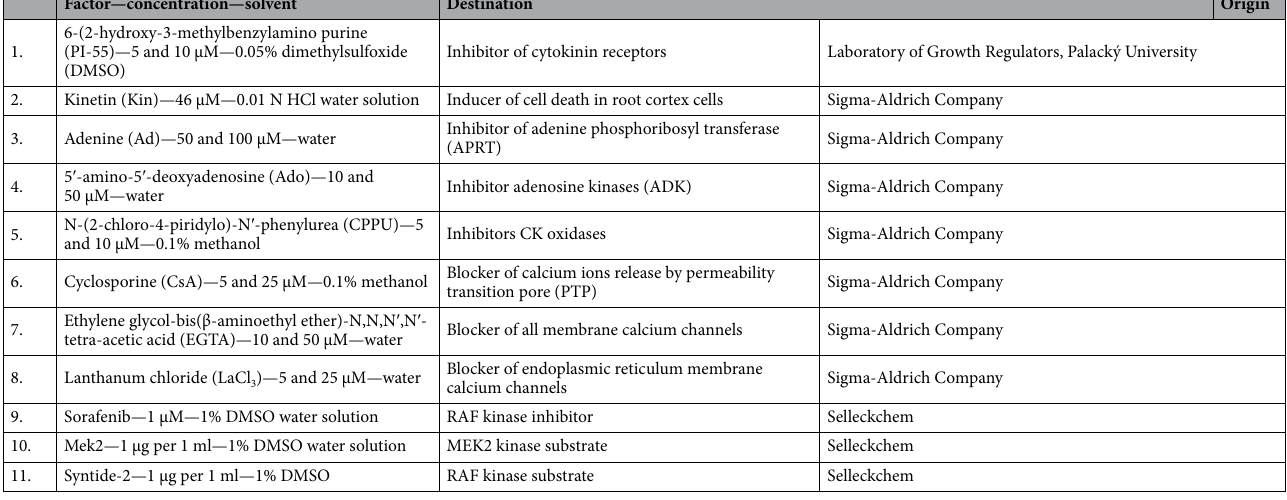
Table 1. The concentrations, solvents, experimental destinations and origin of the modulators of cytokinin reception and metabolisms as well as blockers of calcium ions channels and its release from mitochondria as well as inhibitor of Raf-like kinase activities and RAF and MEK2 kinase substrates applied in the